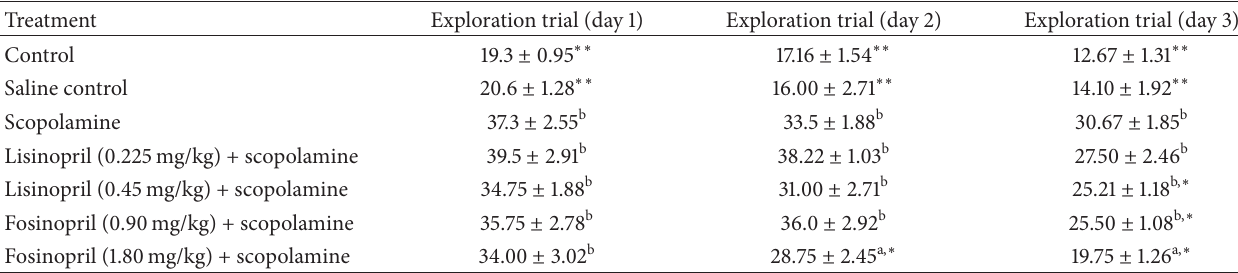
Table 2: Effects of lisinopril and fosinopril on the exploratory behaviour of scopolamine-induced amnesic rats in passive avoidance test.